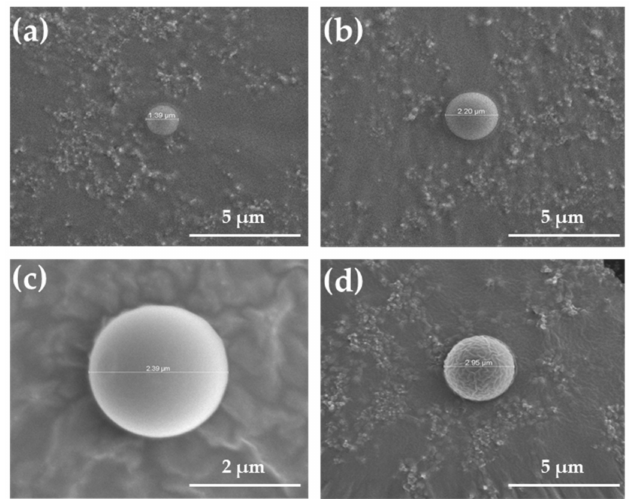
Figure 14. Polymer beads of various sizes, manufactured by an optimized process: ( a ) 1.33 µ m bead, ( b ) 2.2 µ m bead, ( c ) 2.39 µ m bead, and ( d ) 2.95 µ m bead.